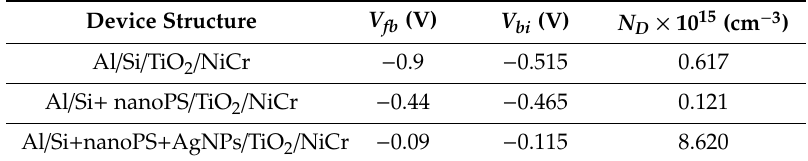
Table 3. AC electrical parameters for the three structures determined from the Mott–Schottky plots at 1 KHz. Device Structure